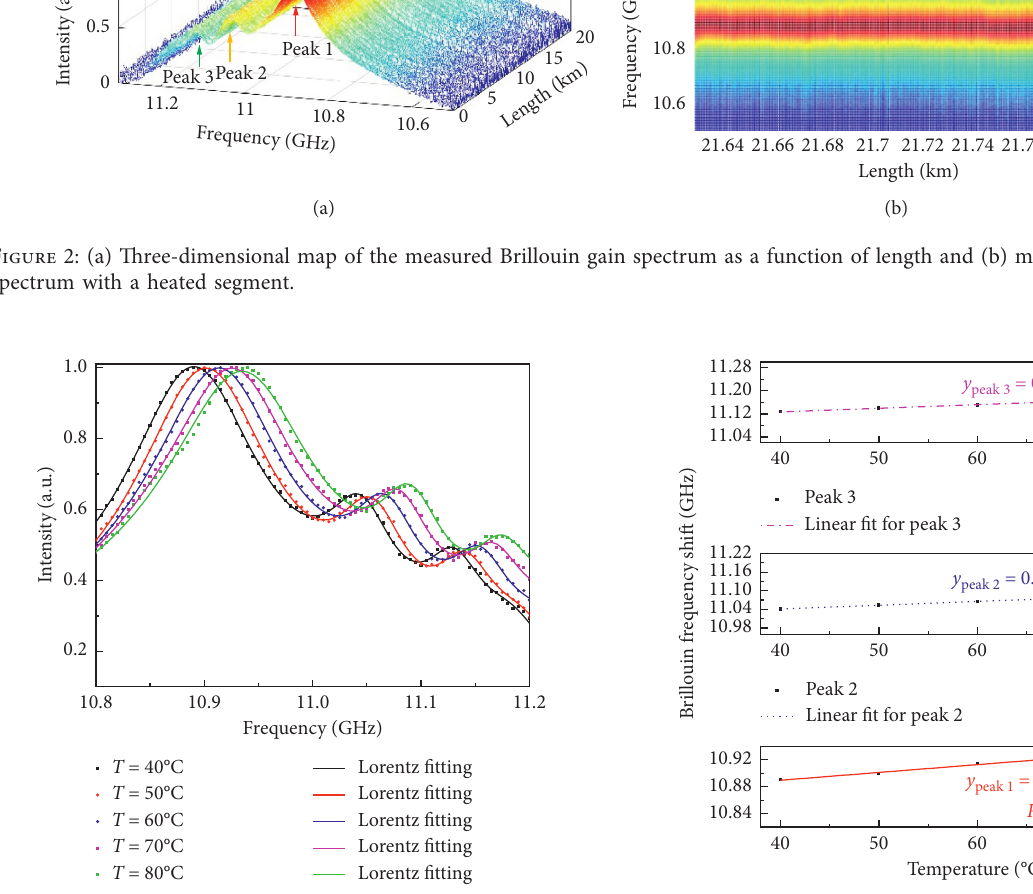
Figure 3: Measured Brillouin gain spectra of multipeak under different temperatures with a step of 10 ° C.